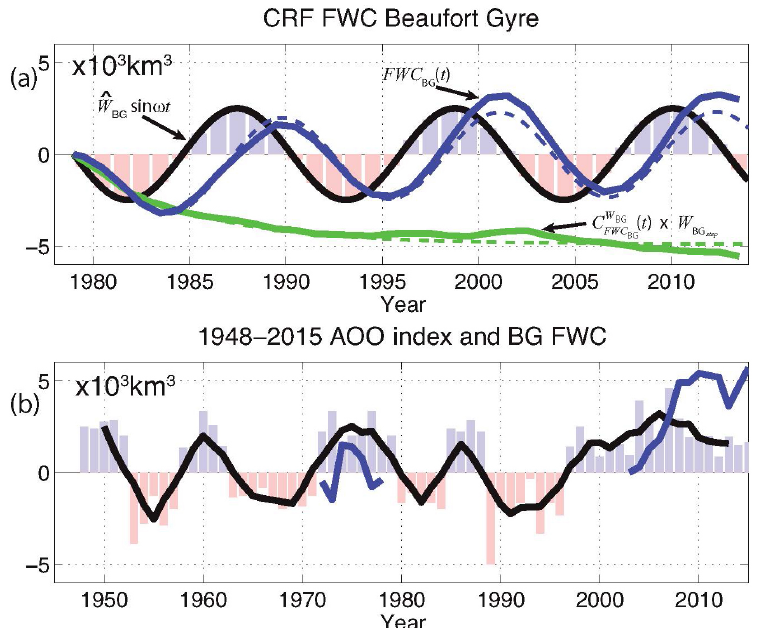
Figure 10. (a) Analytical solution (Eq. 5) for the response of the FWC of the BG (blue dashed line) to a sinusoidal wind W BG of the form Eq. (3) (thick black line) assuming a response function of the form Eq. (4) (green dashed line is a fit to the thick green line which itself is the average of the (abs) plus and minus CRFs from Fig. 6a, plotted as the minus response). The response of the Arctic GCM to the sinusoidal wind forcing is plotted in the same manner in the thick blue line for comparison. (b) The (nondimensional) AOO, an index measuring the intensity of the Beaufort High (bars and thick black line), from 1948–2015 (see Proshutinsky et al., 2015). All lines are 5-year running means. A positive index corresponds to years with an anticyclonic wind stress over the BG, and a negative index is years with a cyclonic wind stress over the BG. The blue line shows observed anomalies of freshwater content (thousands of cubic kilometers) in the BG region. Note that the units of the y axis appear in the top-left-hand corner of each